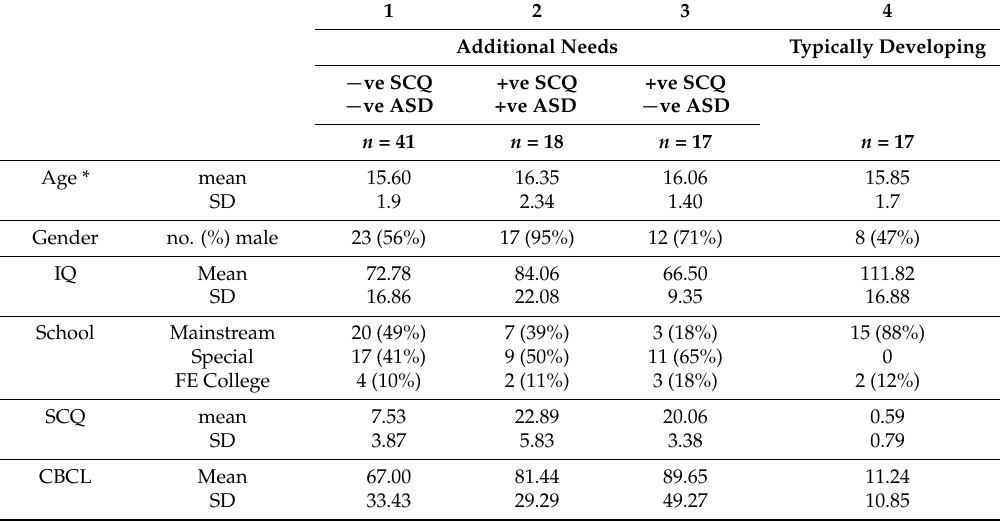
Table 1. Demographic data by group.